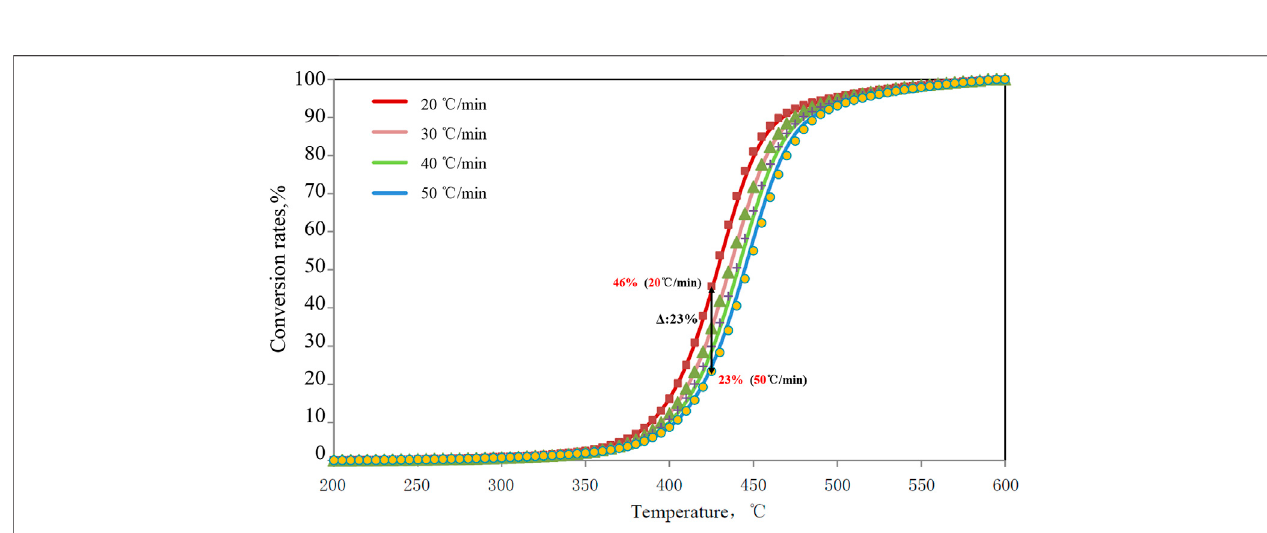
FIGURE 6 | Cumulative hydrocarbon conversion rates of sample 2,910 of the Dongdalongkou section under different heating rates.